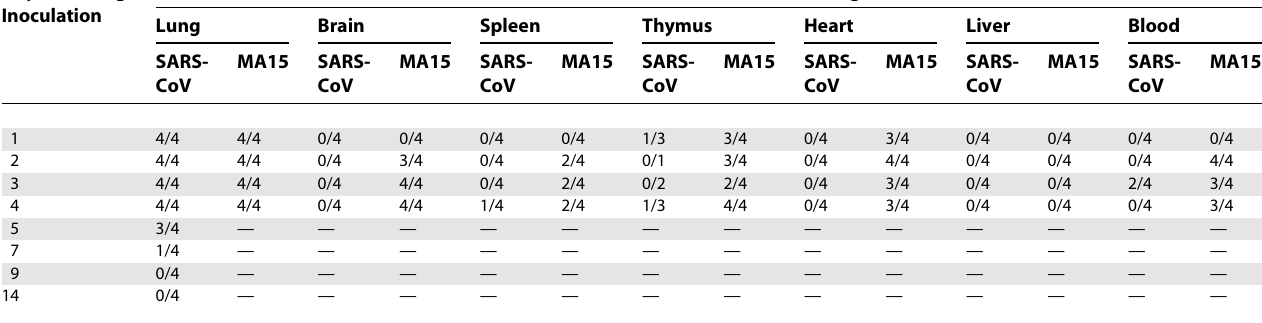
Table 5. Detection of SARS-CoV and MA15 mRNA Day following Inoculation